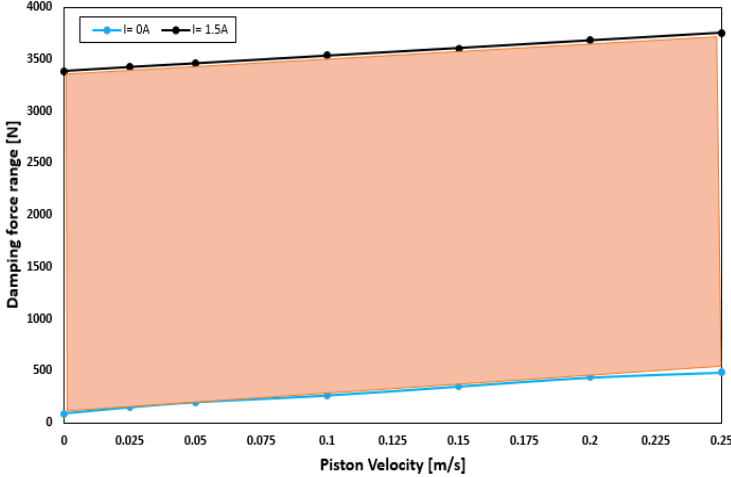
Figure 10. Variation of damping force of the HARMRD with piston velocity with optimized param- eter.